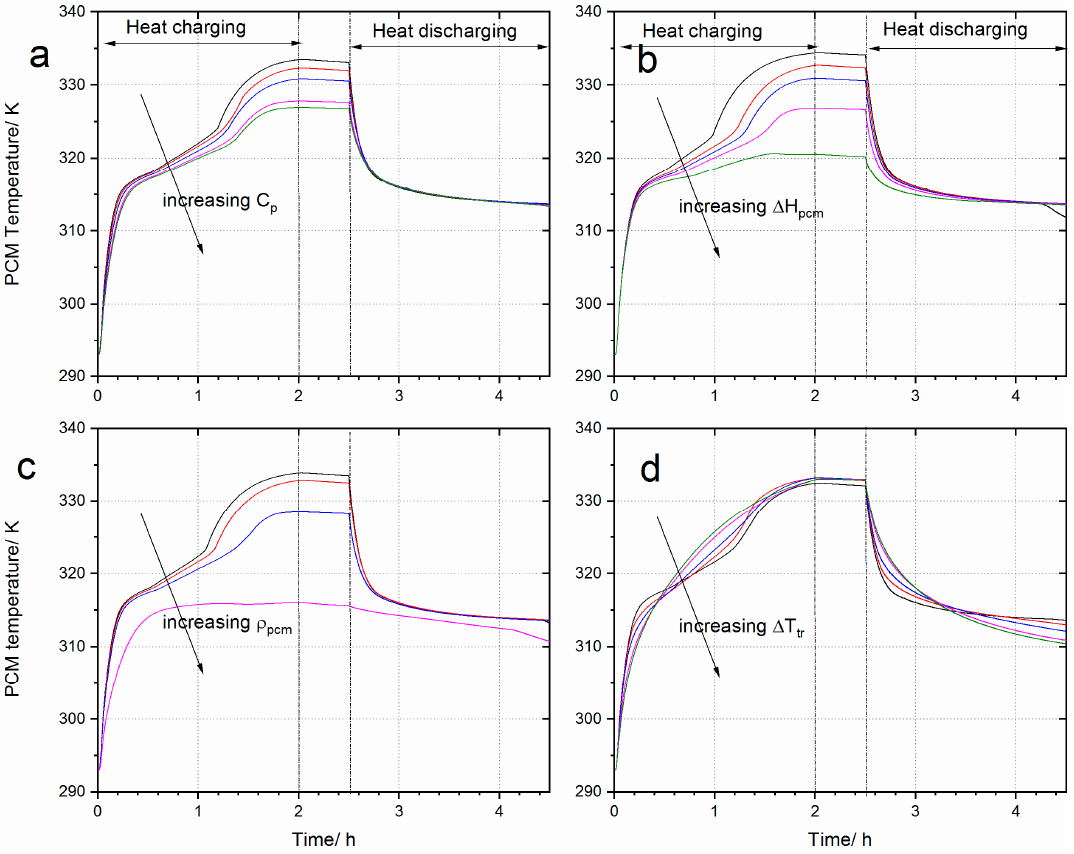
Figure 13. The influence of PCM thermophysical properties on the PCM temperature: ( a ) Heat capacity ( b ) the latent heat of fusion, ( c ) the PCM density, ( d ) the phase transition temperature range. Table 3. The effect of thermo-physical properties of PCM and design parameters on the performance indicators of the heat storage system. Performance Indicators